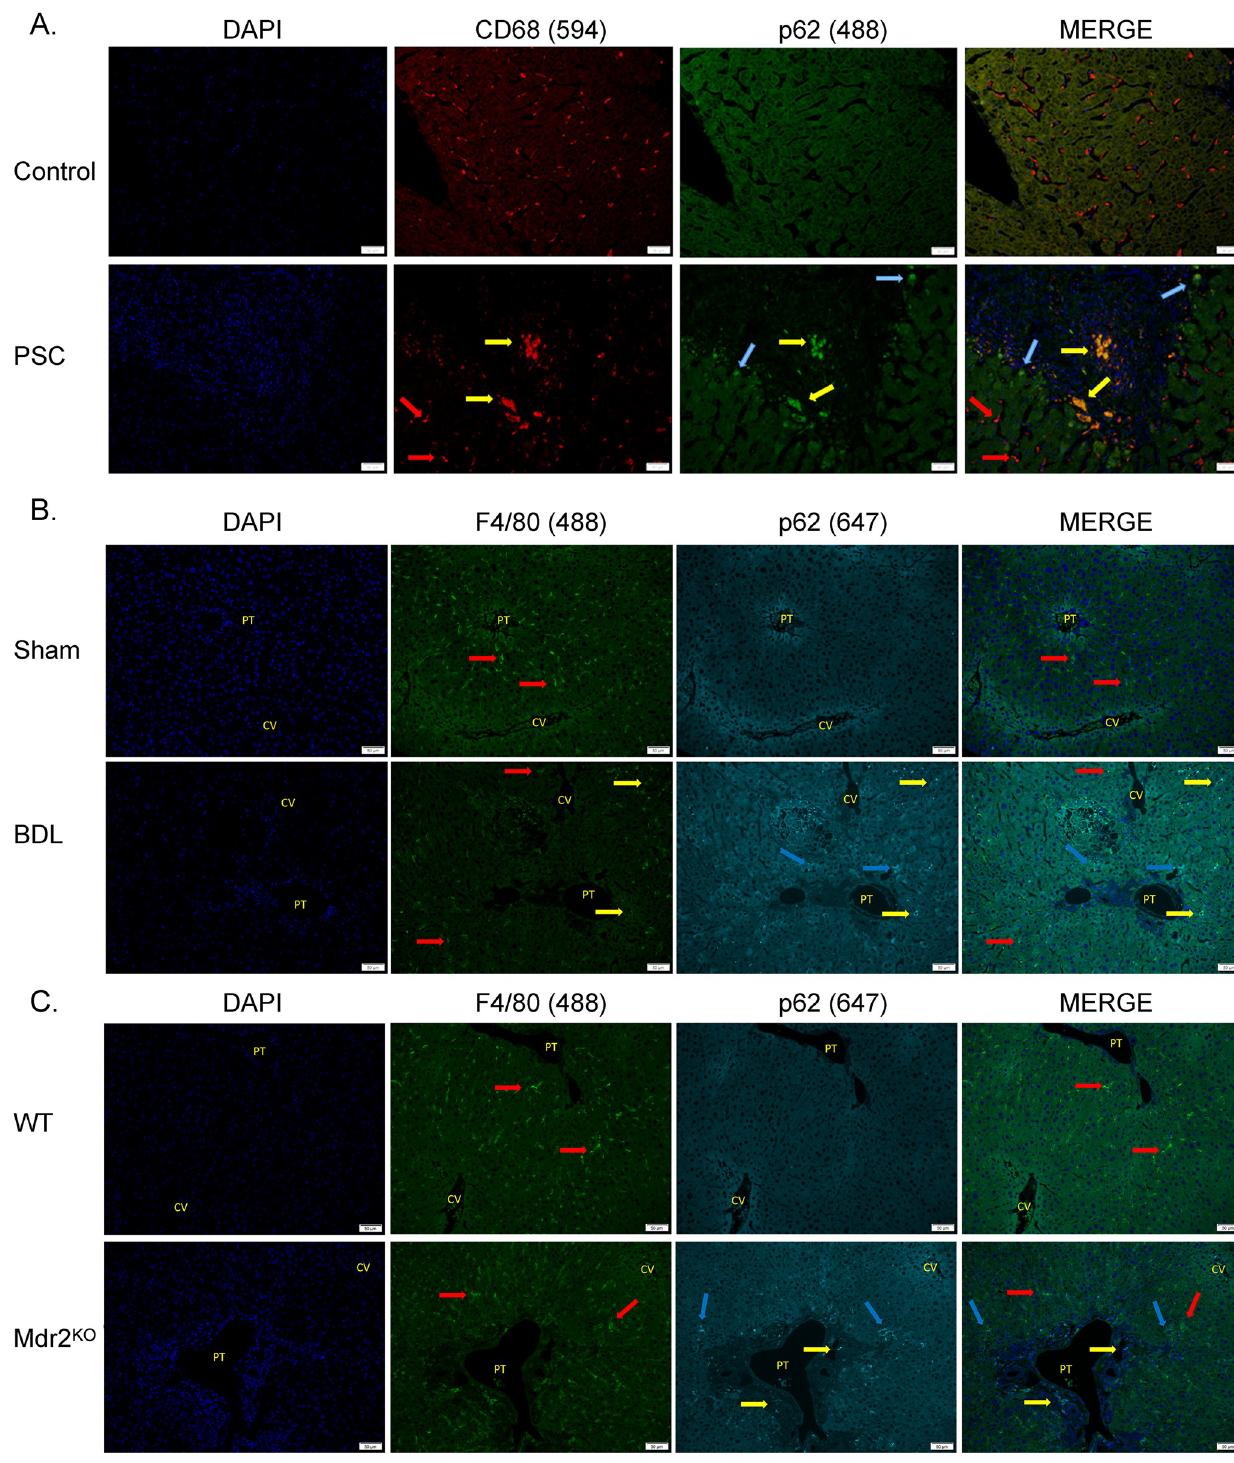
Fig 4. Colocalization of p62 in macrophages during cholestasis. A. Colocalization of p62 and CD68+ macrophages in human PSC. Paraffin embedded formalin fixed tissue sections from normal human PSC liver were analyzed immunohistochemically using a rabbit polyclonal antibody directed against p62, a mouse monoclonal antibody directed against the macrophage marker CD68 followed by FITC 488 conjugated anti-rabbit and Alexa Fluor 594-conjugated anti-mouse secondary antibodies. Figures are representative of hepatic tissue isolated from three Control and four PSC patients respectively, (200X). B-C. Colocalization of p62 and F4/80 positive macrophages in murine cholestasis. Paraffin embedded formalin fixed tissue sections